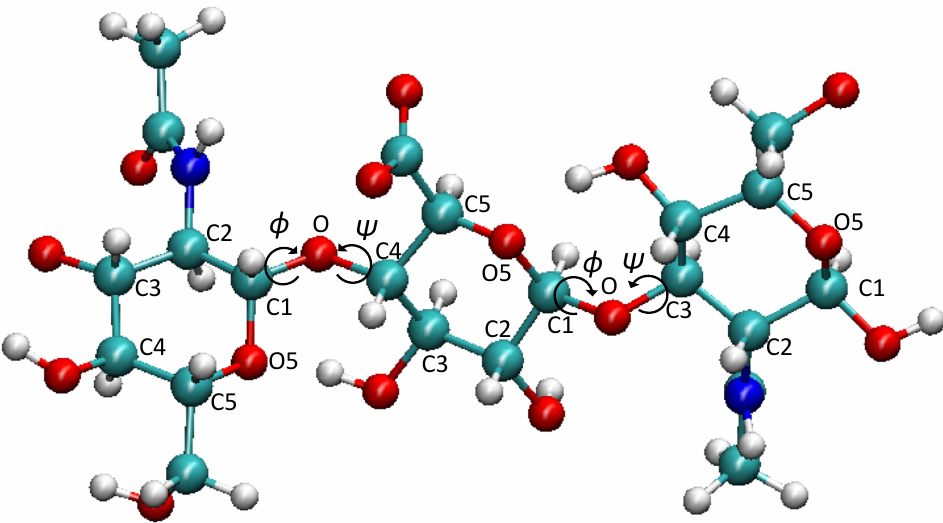
Figure 2. The definition of the dihedral angles φ and ψ is shown for